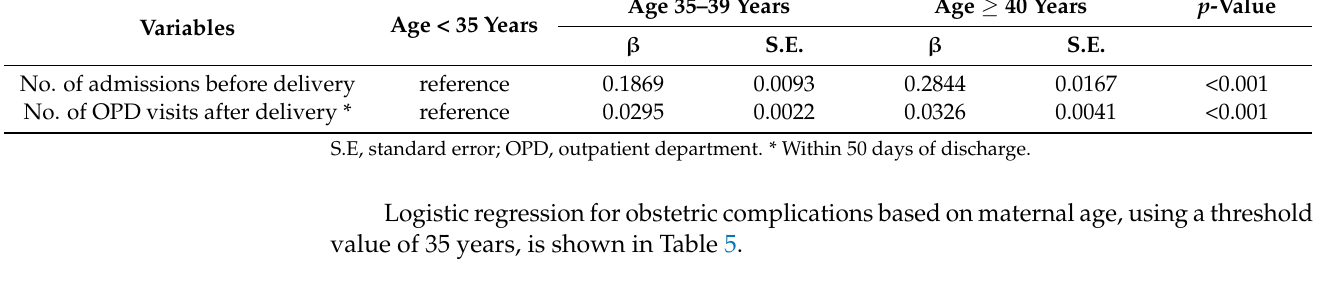
Table 5. Obstetric outcomes by maternal